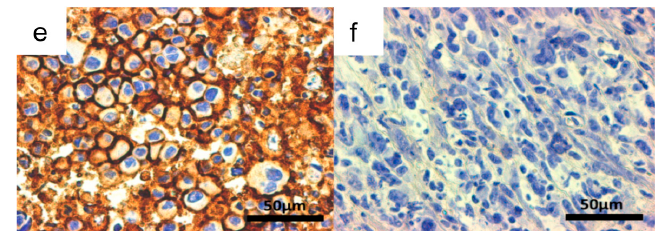
Figure 7. Xenografted tumors image with direct- 99m Tc-chelated dual-imaging probe (red circles). A NIR imager reveals high fluorescence intensity in the SK-BR3 tumor ( right dorsum, a ) in contrast to the MDA-MB231 tumor ( left dorsum, a ) in a single mouse bearing both types of tumors in the direct- 99m Tc-chelated dual-imaging probe studies. The NIR image was taken after skin incision over the xenografted tumors. The tumor-to-muscle ratios of fluorescence intensity and radioactivity were higher in the SK-BR3 tumor than in the MDA-MB231 tumor. Specific tumor uptake is not confirmed by a small γ camera with acquisition time 30 s in the lower-body image ( b ). Excised SK-BR3 tumors exhibit a higher fluorescence intensity in a NIR imager image ( c , upper right ) and a higher radioactivity in an FLA-2000 image ( d , upper right ) than do muscle tissue and MDA-MB231 tumors ( c , bottom right , d , bottom right ). The size of the SK-BR3 tumor is 13 mm × 8 mm × 2 mm and the size of the MDA-MB231 tumor is 6 mm × 8 mm × 5 mm ( c , d ). HER2 immunohistochemistry reveals stronger positive stains in the SK-BR3 tumor cells ( e ) than in the MDA-MB231 tumor cells ( f ).